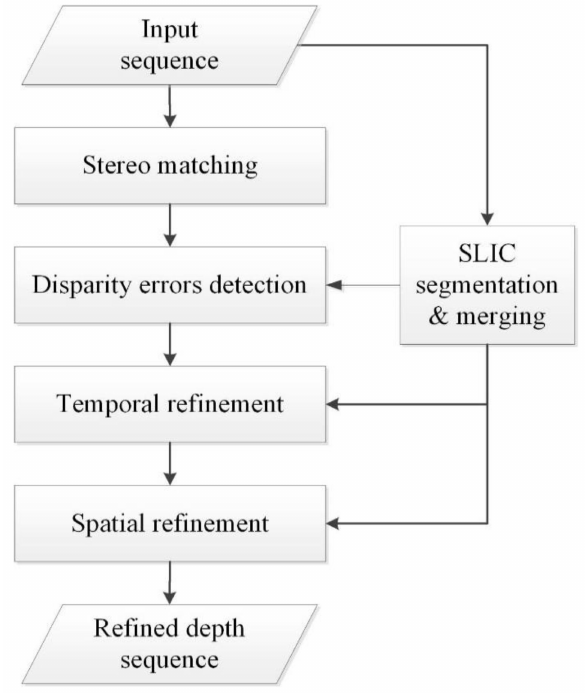
Figure 3. Flowchart of proposed